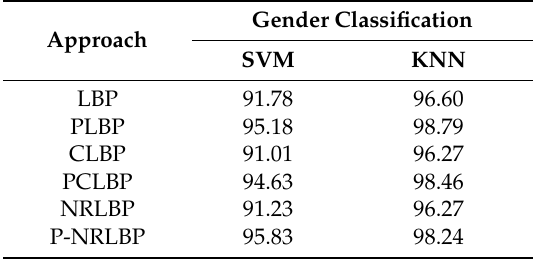
Table 4. Classification Rates for Gender for YVCb (PICS database).